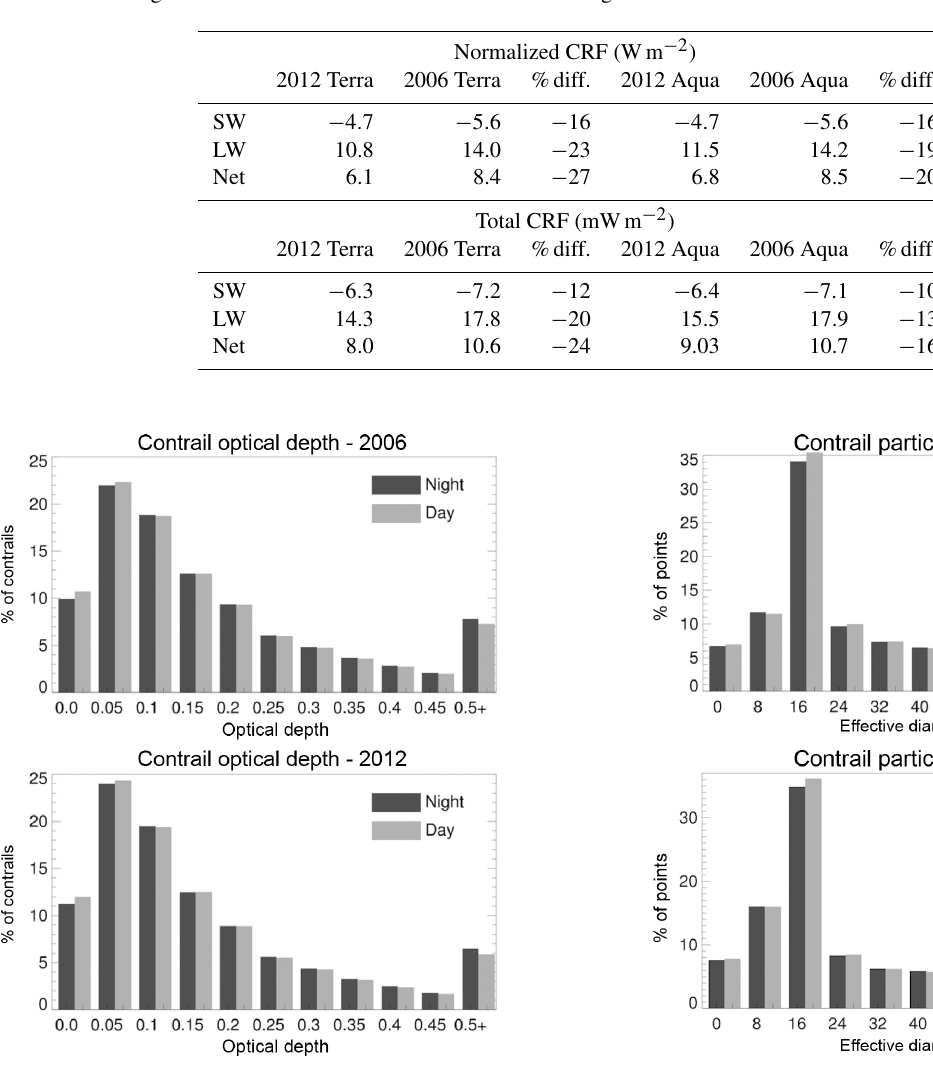
Table 4. Relative change in normalized and total contrail radiative forcing between 2006 and 2012 for the Northern Hemisphere.